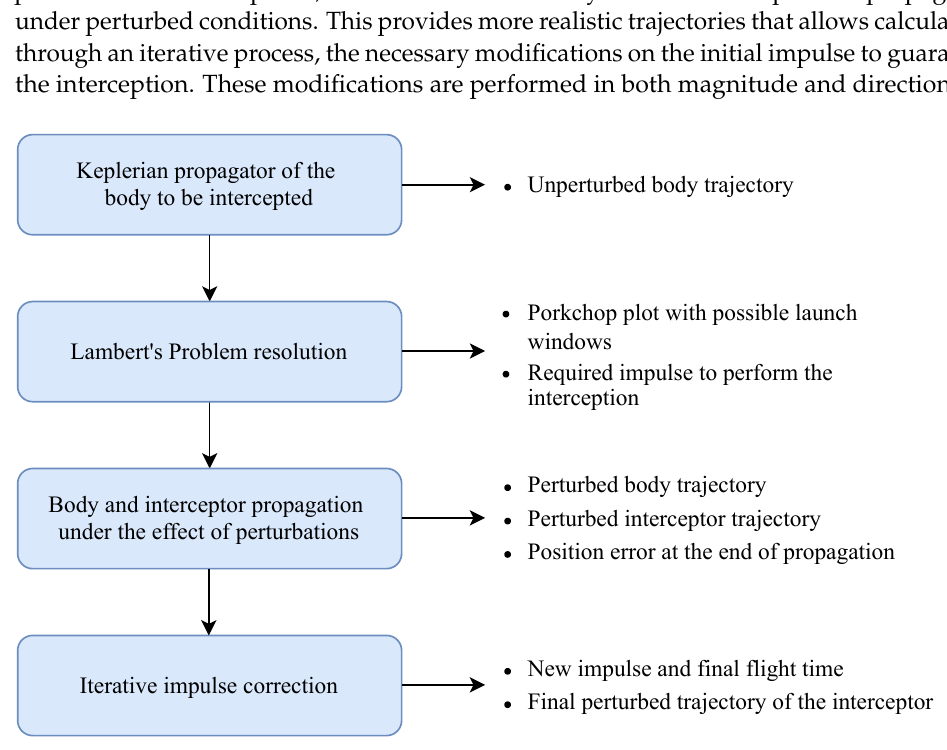
Figure 1. Scheme of the optimal interception trajectory